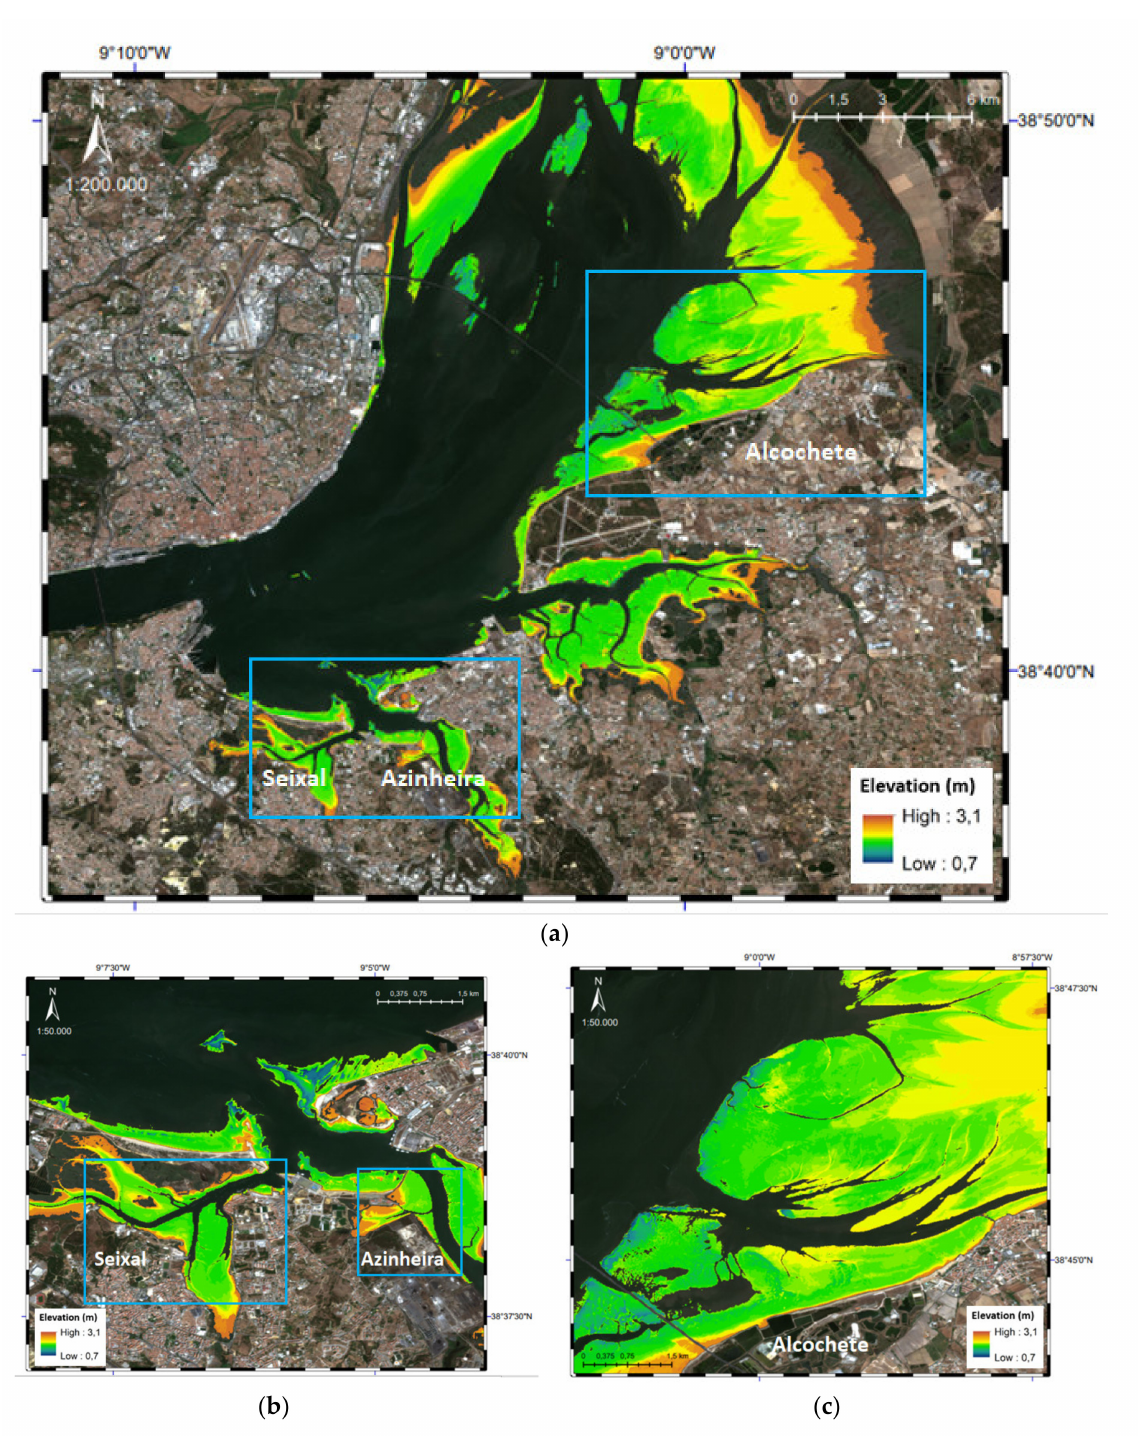
Figure 9. ( a ) Tagus estuary intertidal model estimated using the logistic regression method and 18 S2 images (red: 3.1 m and dark blue: 0.7 m). The two blue rectangles highlight specific intertidal areas at the Tagus estuary (bottom left—Seixal and Azinheira; top right—Alcochete), ( b ) zoom on the intertidal model estimated for the Tagus estuary—Seixal and Azinheira areas, and ( c ) zoom on the intertidal model estimated for the Tagus estuary—Alcochete